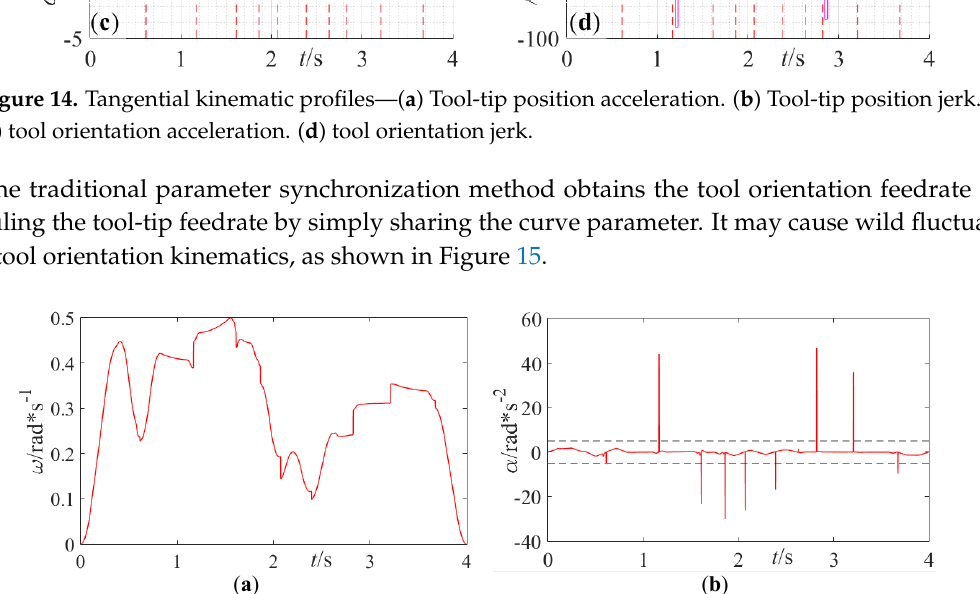
Figure 15. Tool orientation kinematic profiles using parameter synchronization—( a ) Feedrate profile. ( b ) Tangential acceleration